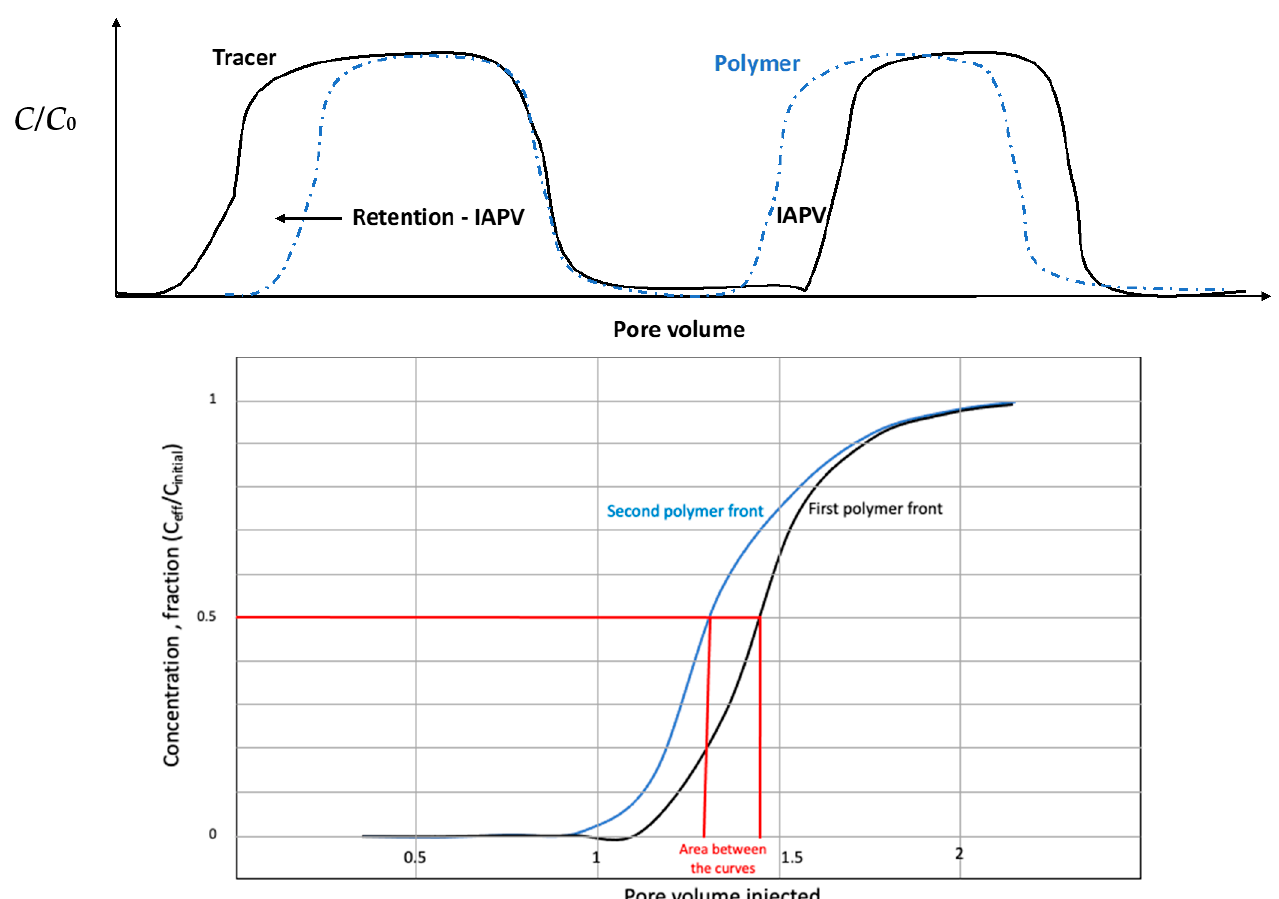
Figure 2. Example of retention calculation using the 2-fronts method. The first figure shows the overall principle of the method and how to calculate inaccessible pore volume. Once the polymer curves are normalized ( C / C 0 which is the ratio of measured concentration and initial concentration), the retention is calculated by considering the area between both curves (first & second fronts). The value is taken at the 0.5 cutoff for the ratio C eff / C i , being concentration in the effluents and initial concentration respectively.